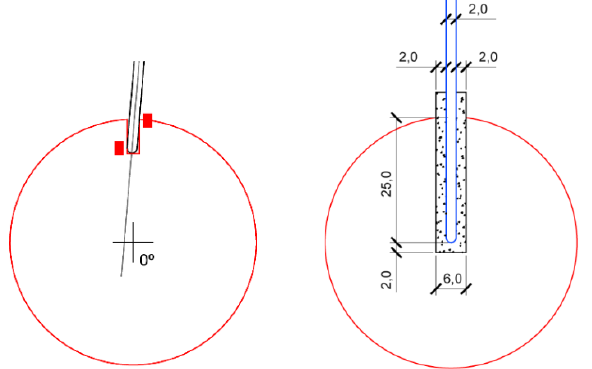
Fig. 16 Contact areas (red) between glass and metallic roller and proposed